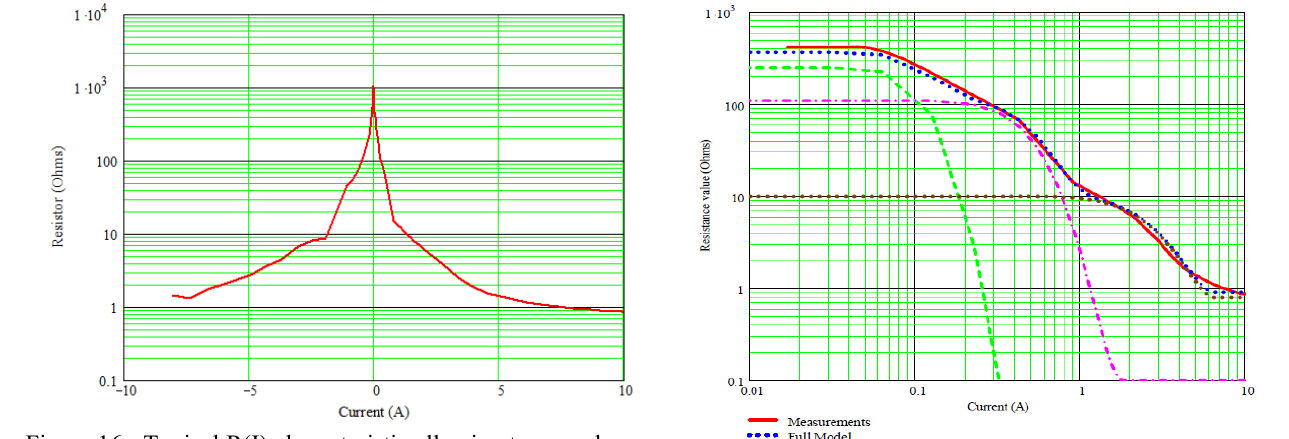
Figure 16: Typical R(I) characteristic allowing to reproduce the snapback effect.